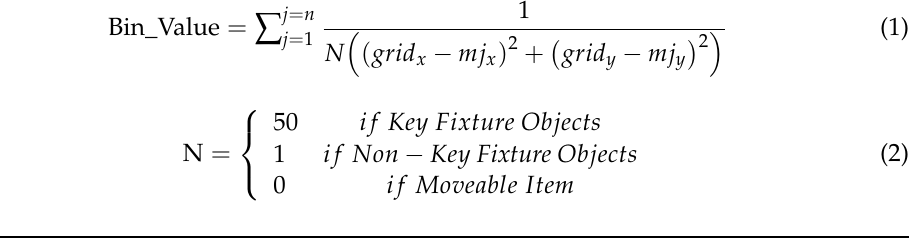
Algorithm 2: Agent Section Segmentation